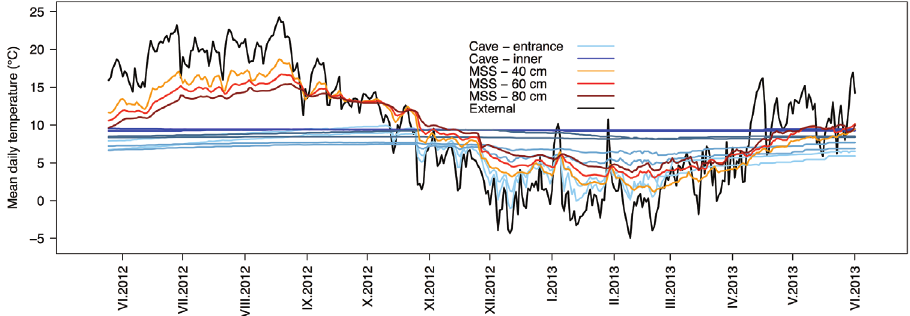
Figure 4. Annual trends of temperatures in the Pugnetto hypogean complex. The shade of blues indicate the relative position of the dataloggers at each cave-triplet, from the outermost (lighter blues) to the in- nermost sections (darker blues). Records from only one MSS - triplet are